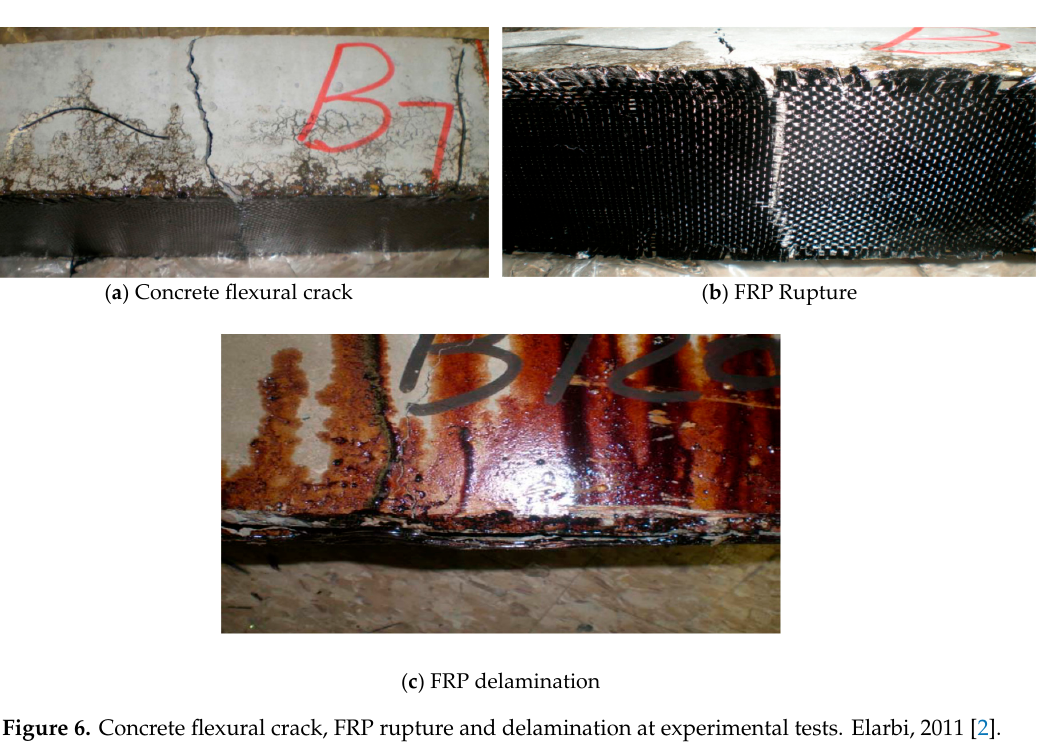
Figure 5. Load and boundary conditions of FRP strengthened column model. ( a ) Mesh of concrete by size; ( b ) Mesh of FRP by size.